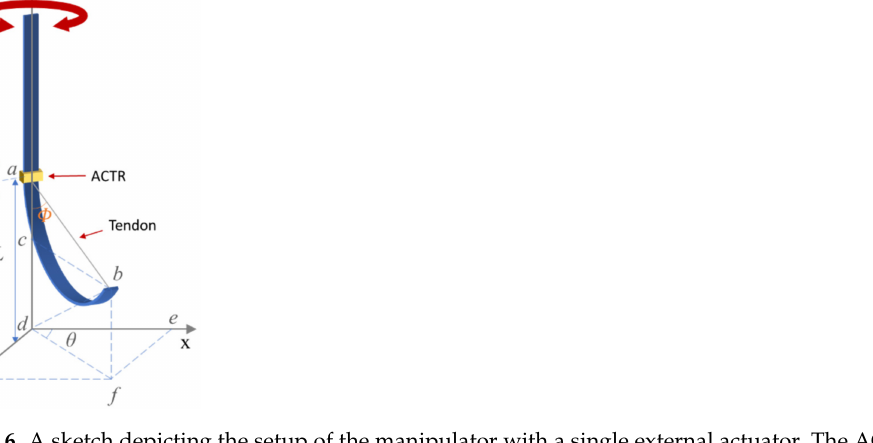
Figure 6. A sketch depicting the setup of the manipulator with a single external actuator. The ACTR can be relocated anywhere along the manipulator’s